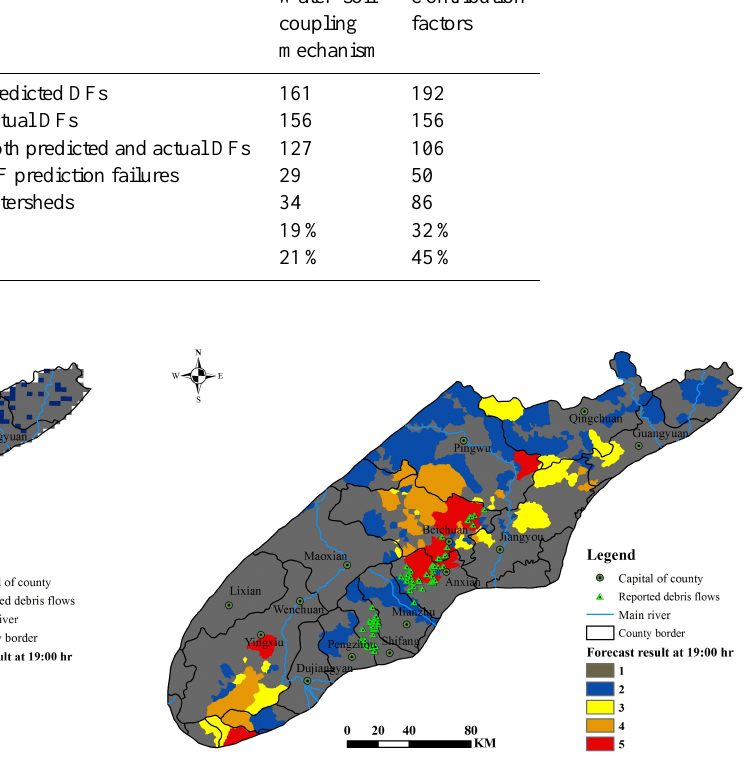
Figure 13. Transformation of results via the rule of highest warning level.